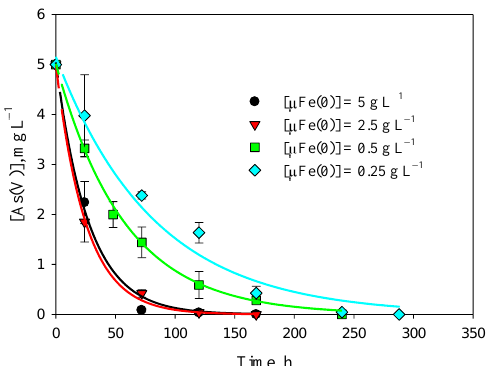
Figure 1. Temporal profiles of As(V) concentration in contact with different doses of μFe(0). Condi- tions: [As(V)] 0 = 5 mg L −1 , pH 7, RT, EC = 0.03 mS cm −1 , without stirring. Error bars represent the standard deviation between duplicates, while full lines are the adjustment to a pseudo-first-order kinetics using Equation (3).